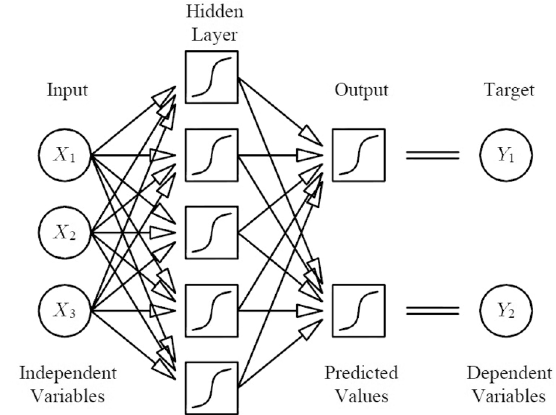
Fig. 1. Multilayer perceptron neural network (Sarle